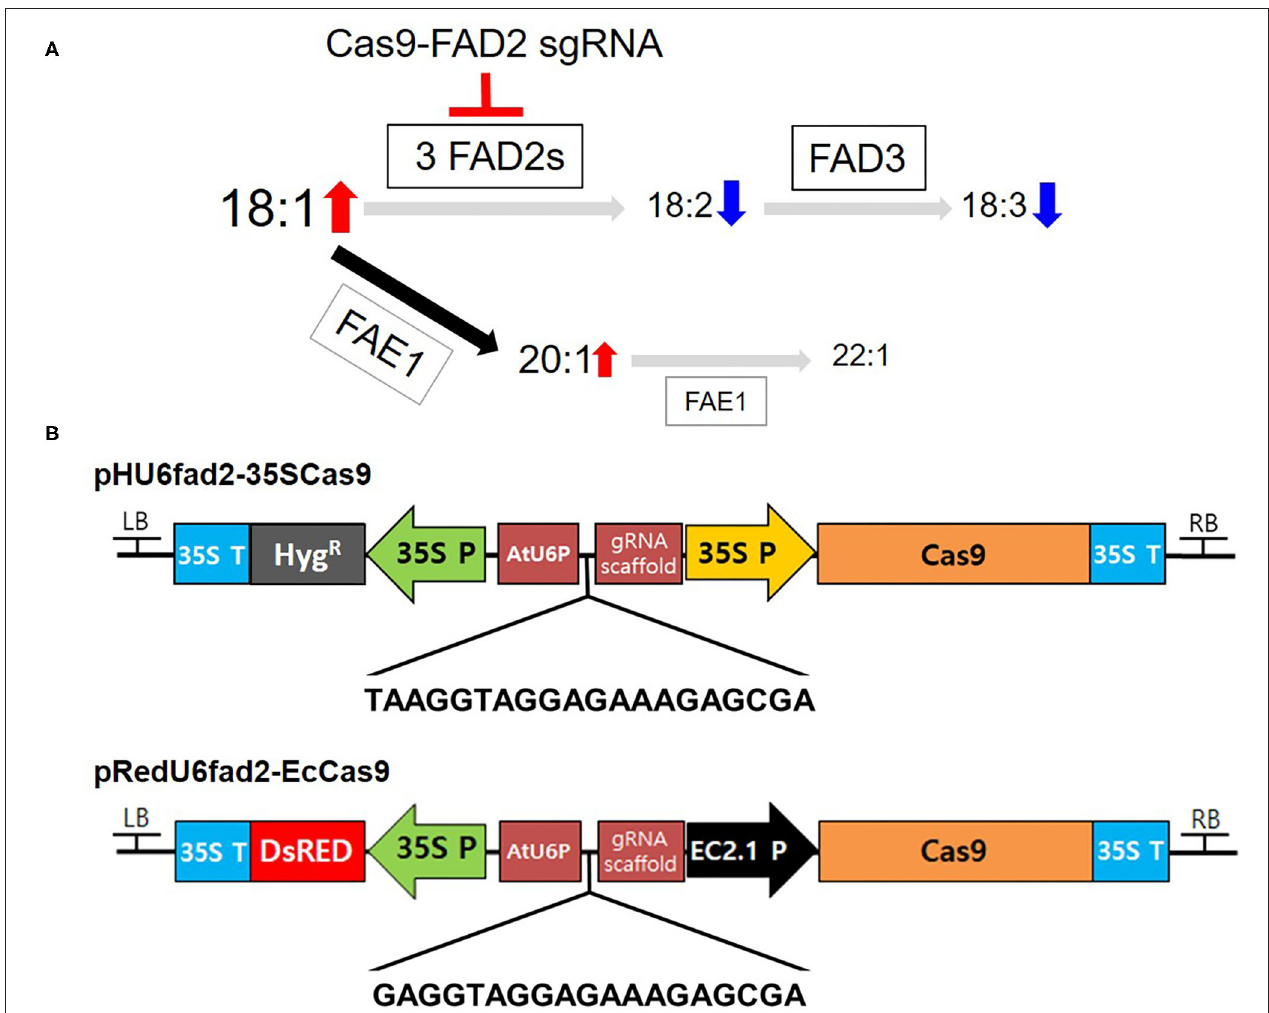
FIGURE 1 | Binary vectors for CsFAD2 KO in Camelina. (A) Simplified schematic diagram of genes encoding enzymes involved in fatty acid synthesis and metabolism in Camelina seeds. Cas9-FAD2 sgRNA was constructed to edit three copies of FAD2 genes in Camelina. Seed fatty acids are synthesized sequentially from 18:1 to 18:2 by FAD2 and 18:3 by FAD3. In addition, 18:1 is synthesized as 20:1 and 22:1 by FAE1. The font size of fatty acids represents the increase and decrease in fatty acid content predicted as a result of FAD2 editing. Gray arrows indicate a decrease and black arrow indicates an increase in metabolic flow. (B) The pHU6fad2-35SCas9 construct containing the hygromycin phosphotransferase ( Hyg R ) gene as a selection marker and the 35S promoter (35S P) to drive Cas9 . The pRedU6fad2-EcCas9 construct containing DsRed as a selection marker and the egg-specific EC1.2 promoter to drive Cas9 expression. Both vectors contain